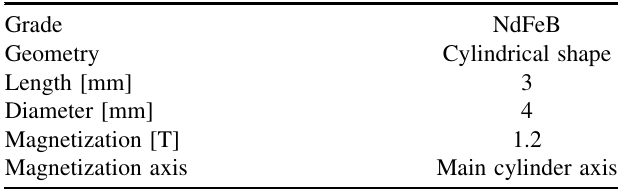
TABLE III. Characteristics of magic finger magnets.